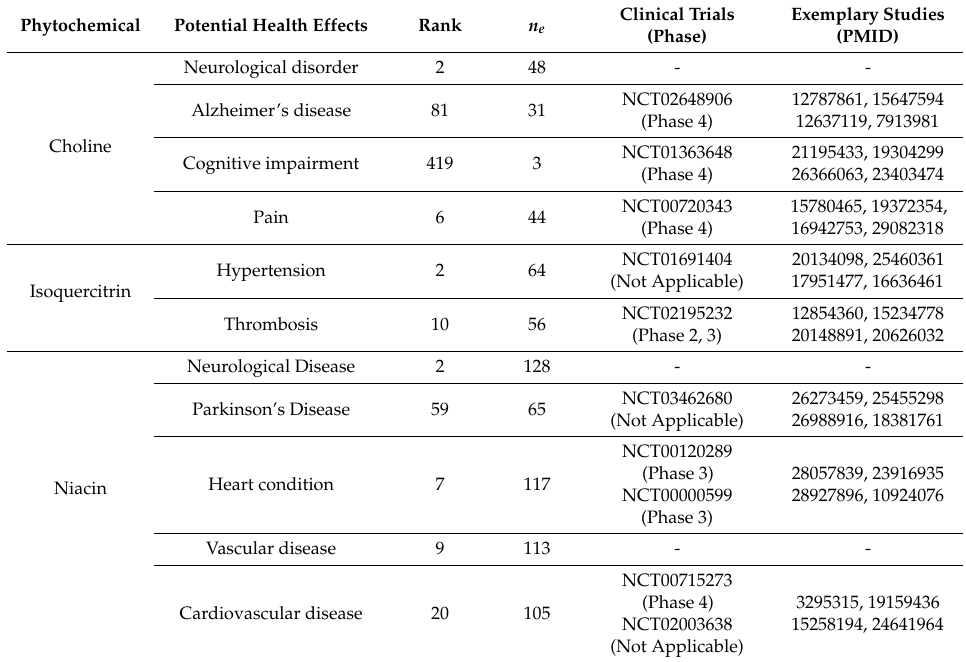
Table 6. Summary of evidence indicating potential health effects of exemplary phytochemicals: isoquercitrin, niacin and